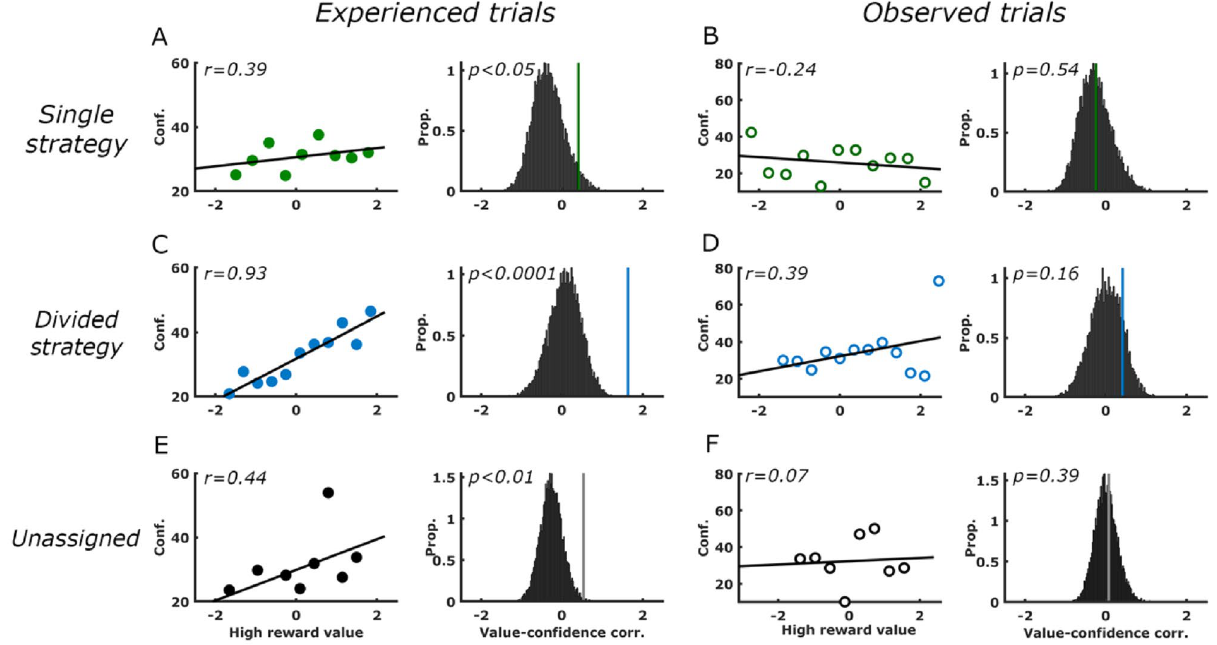
Figure 5. Confidence ratings are positively associated with maximum cue-values during experienced trials. Scatter plots here and below depict correlations between subjective memory strength (measured as mean confidence ratings) with the maximum stimulus-value available in a trial. ( A , C , E ). Correlations between memory performance and high reward values during experienced trials for the single-strategy, divided-strategy, and unassigned groups, respectively. All correlations were tested against 10,000 shuffles of each subject’s data (right panels). Actual correlations are represented by vertical lines in relation to the histogram of shuffled data. ( B , D , F ) Similar analysis as in left panels for observed